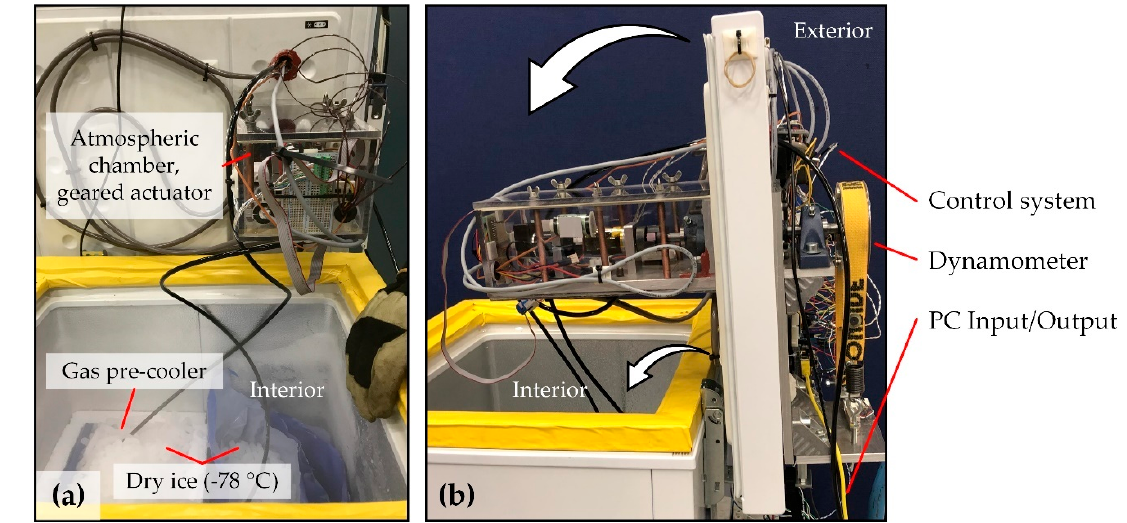
Figure 6. Assembled geared actuator test rig in open position. ( a ) Details of refrigerated interior side. ( b ) Side view .